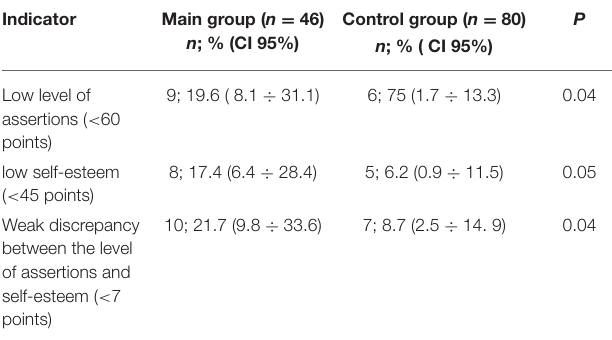
TABLE 5 | Level of self-esteem and assertions in children with